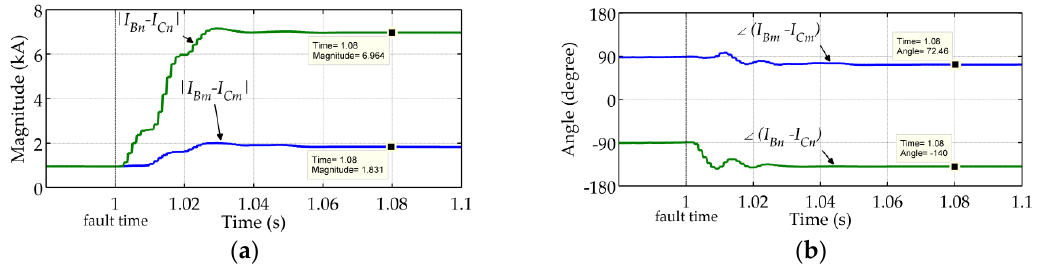
Figure 7. Current difference of fault phases at each side of line mn: ( a ) Magnitudes; ( b ) Phase angles.